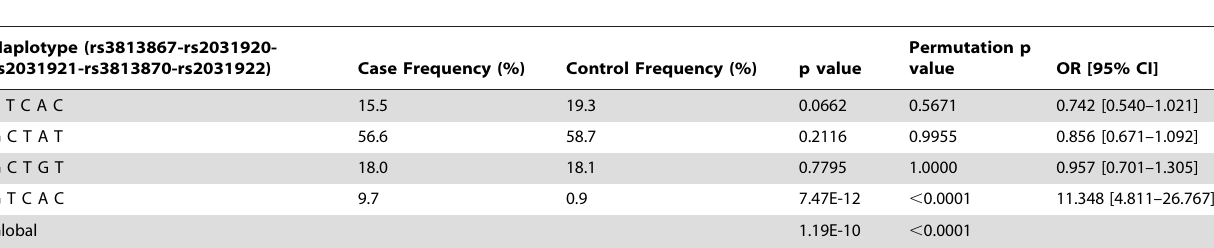
Table 2. Estimated CYP2E1 haplotype frequencies and p values among cases and